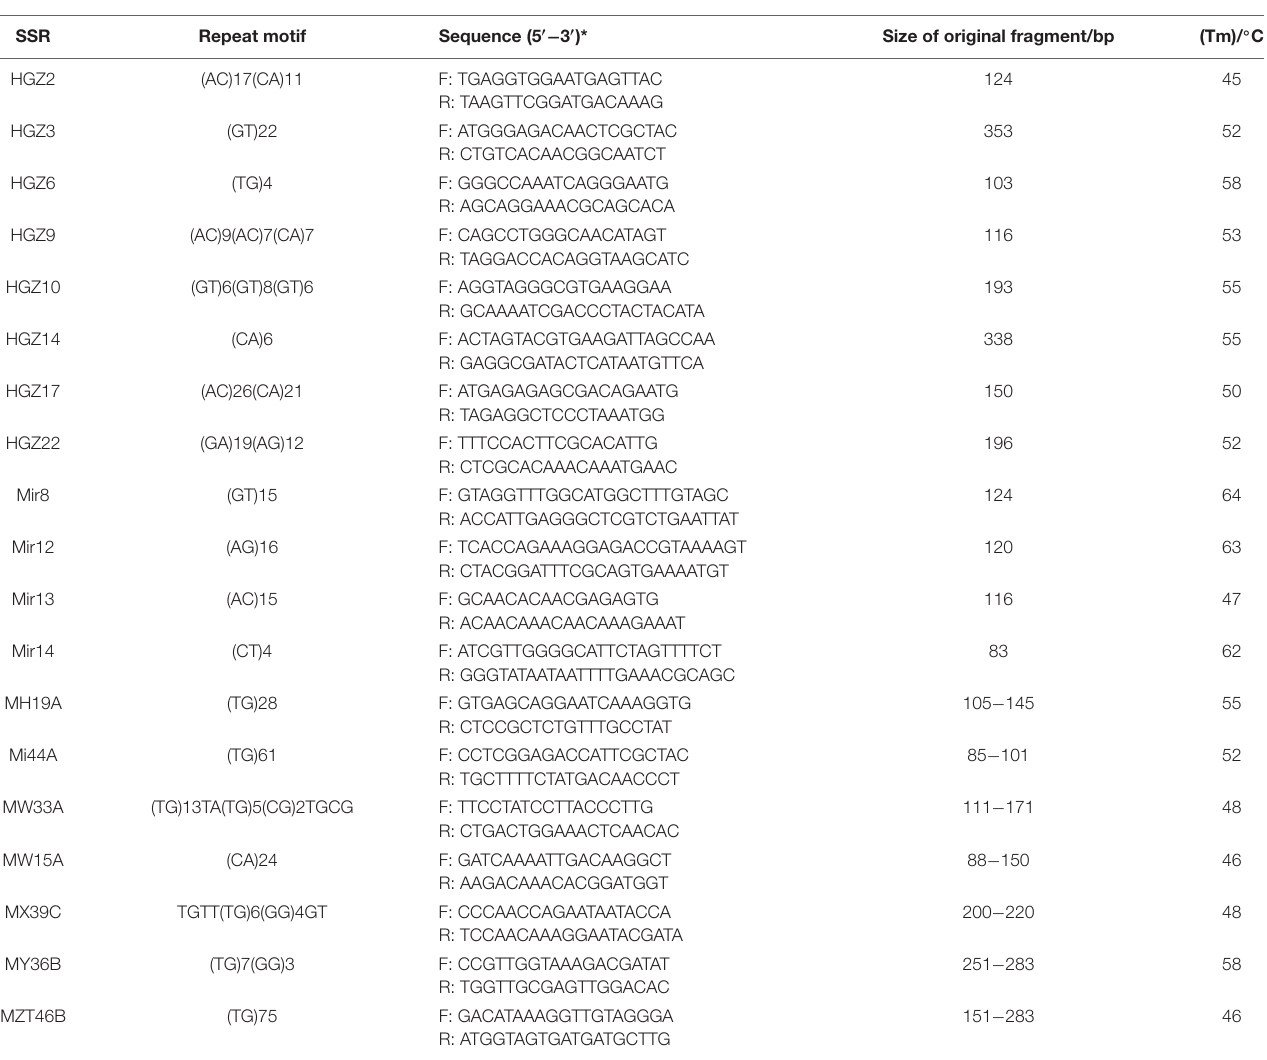
TABLE 2 | Microsatellite primer